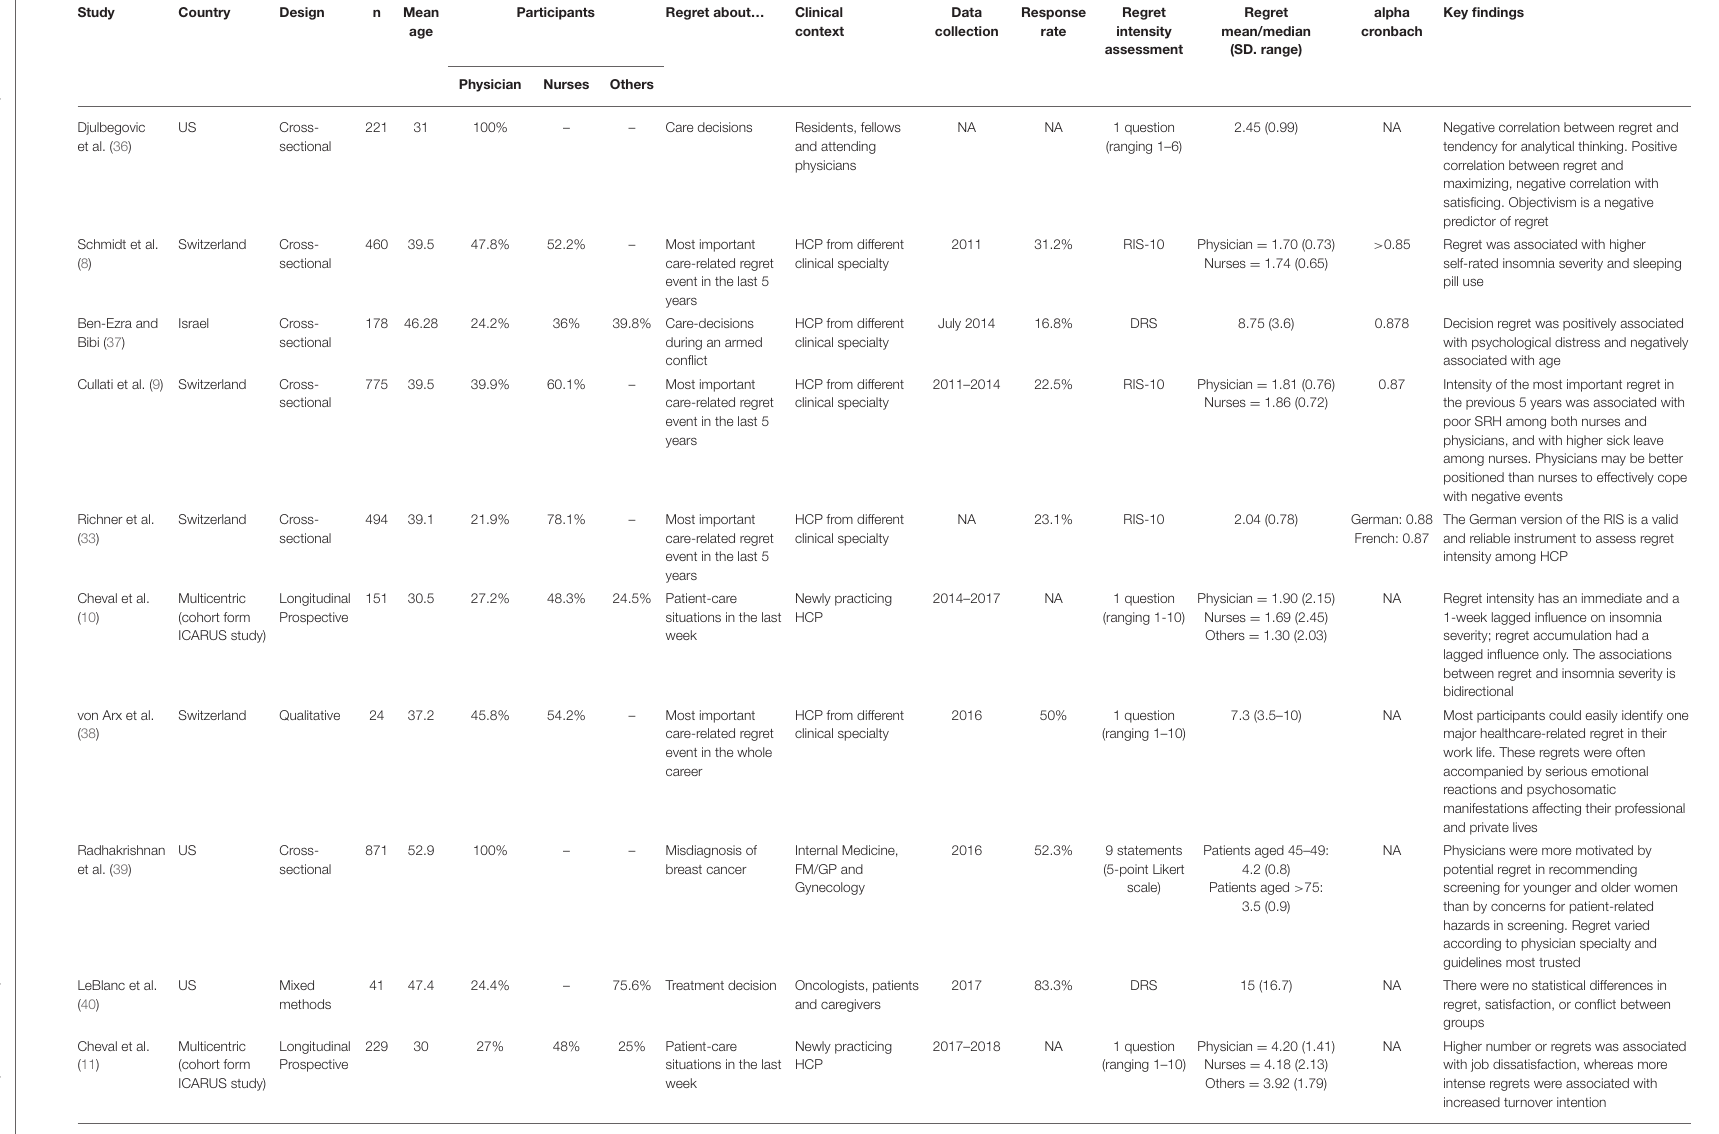
TABLE 2 | Literature